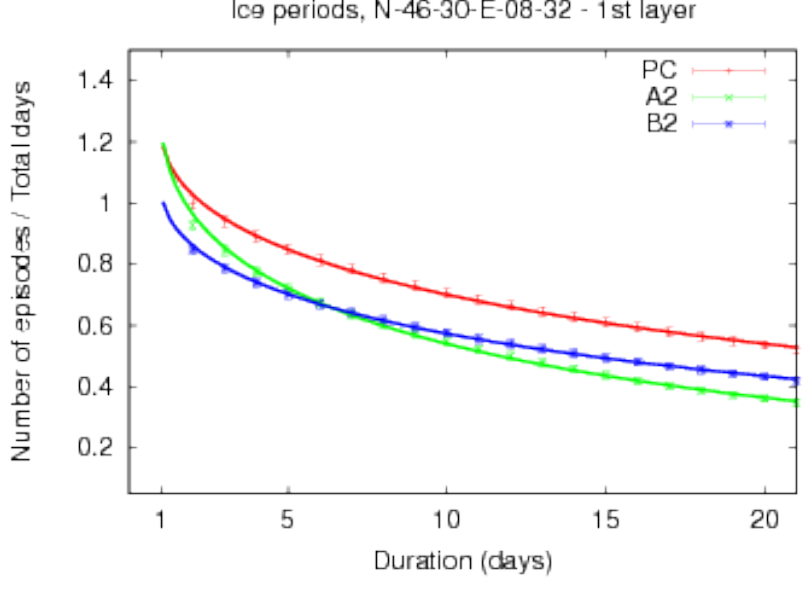
Figure 3. Frequency of cold spells versus their duration: the case in which A2 and B2 curves cross each